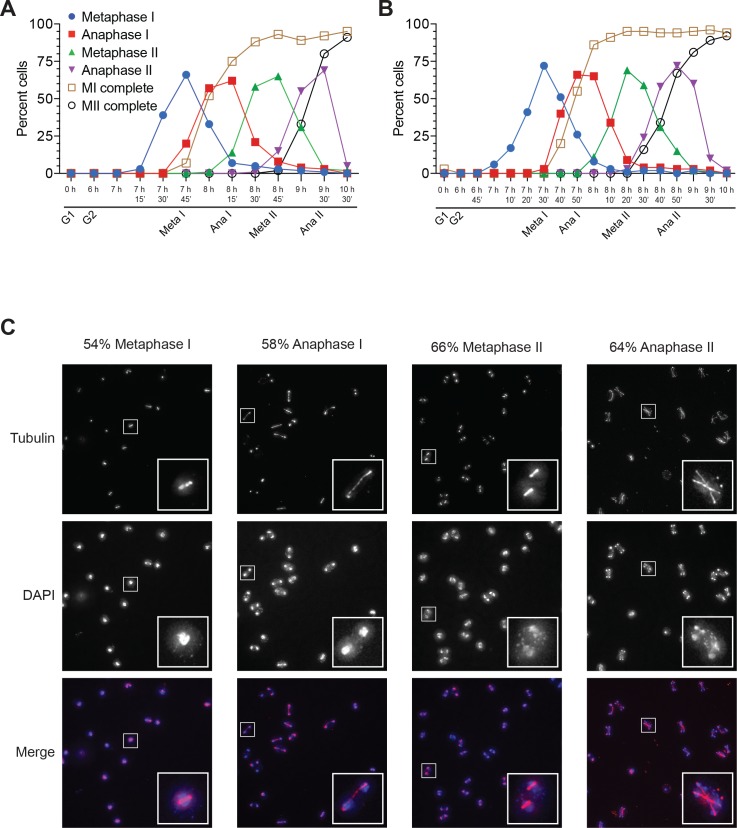
Cells from Figure 1 proceeded synchronously through meiosis.(A) Cell–cycle stage quantification for Figure 1B. (B) Cell–cycle stage quantification for Figures 1C and 2A. (C) Representative micrographs from a separate experiment showing the peak time point of metaphase I, anaphase I, metaphase II, and anaphase II. Insets show an enlarged cell from that cell-cycle stage. Percent of cells in that stage written above the micrographs (based on counting 100 cells). Top: tubulin, middle: DAPI, bottom: merge (red = tubulin, blue = DAPI).